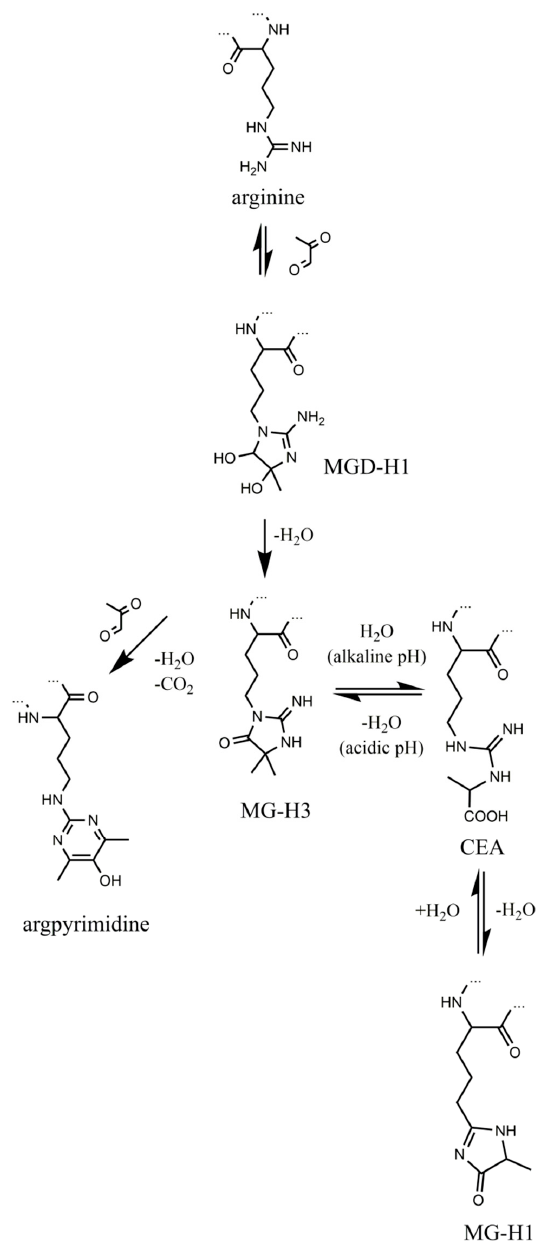
Figure 1. Formation and transformation of methylglyoxal-derived advanced glycation end products (AGEs). The “…” sign indicates polypeptide chain.